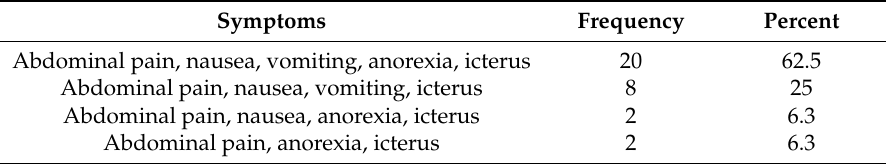
Figure 1. The location of the masses in the periampullary region. Table 1. Frequency of the patients’ symptoms among the study population.